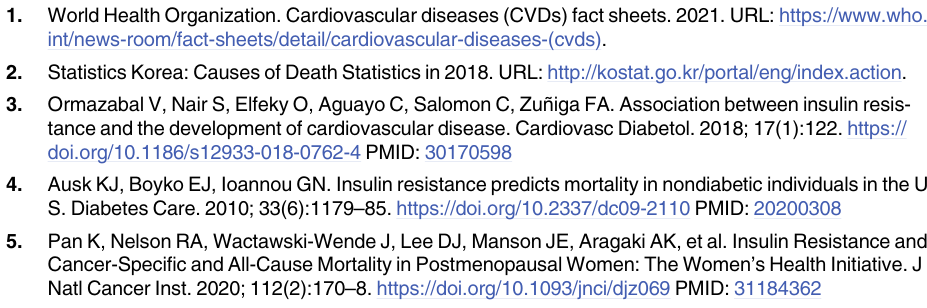
S1 Table. Two-way ANOVA for the continuous variables and log-linear models with two- way interaction for the categorical variables by sex and TyG index quartile. S2 Table. Cox-proportional hazards regression model for the primary outcomes (cardio- cerebrovascular diseases or all-cause death) according to TyG index